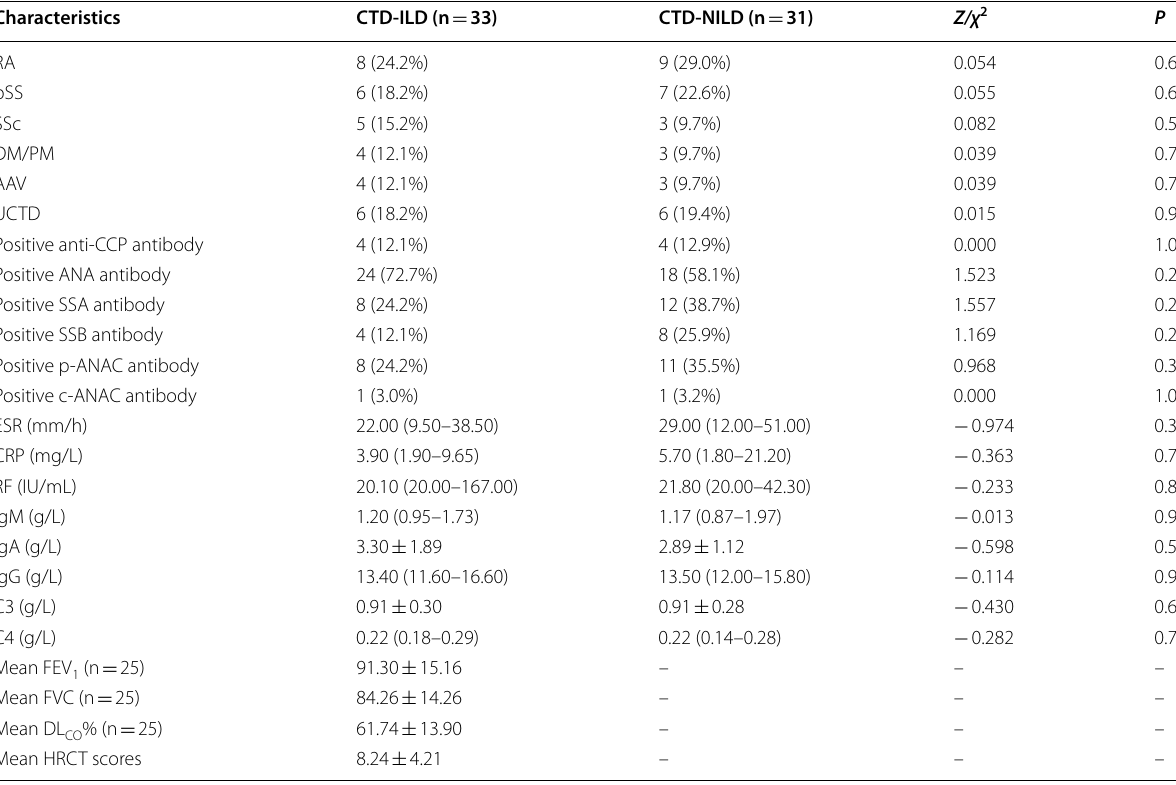
ESR erythrocyte sedimentation rate, CRP C-reactive protein, RF rheumatoid factors, NEU neutrophilic granulocyte, HGB hemoglobin, RA rheumatoid arthritis, SSc systemic sclerosis, PM polymyositis, DM dermatomyositis, pSS primary Sjogren syndrome, UCTD undifferentiated connective tissue disease, AAV anti- neutrophil cytoplasmic antibody associated vasculitis, ANA antinuclear antibody, ANCA anti- neutrophil cytoplasmic antibody, C3 complement C3, IgM immunoglobulin M, SSA anti-Sjogren syndrome A antibody